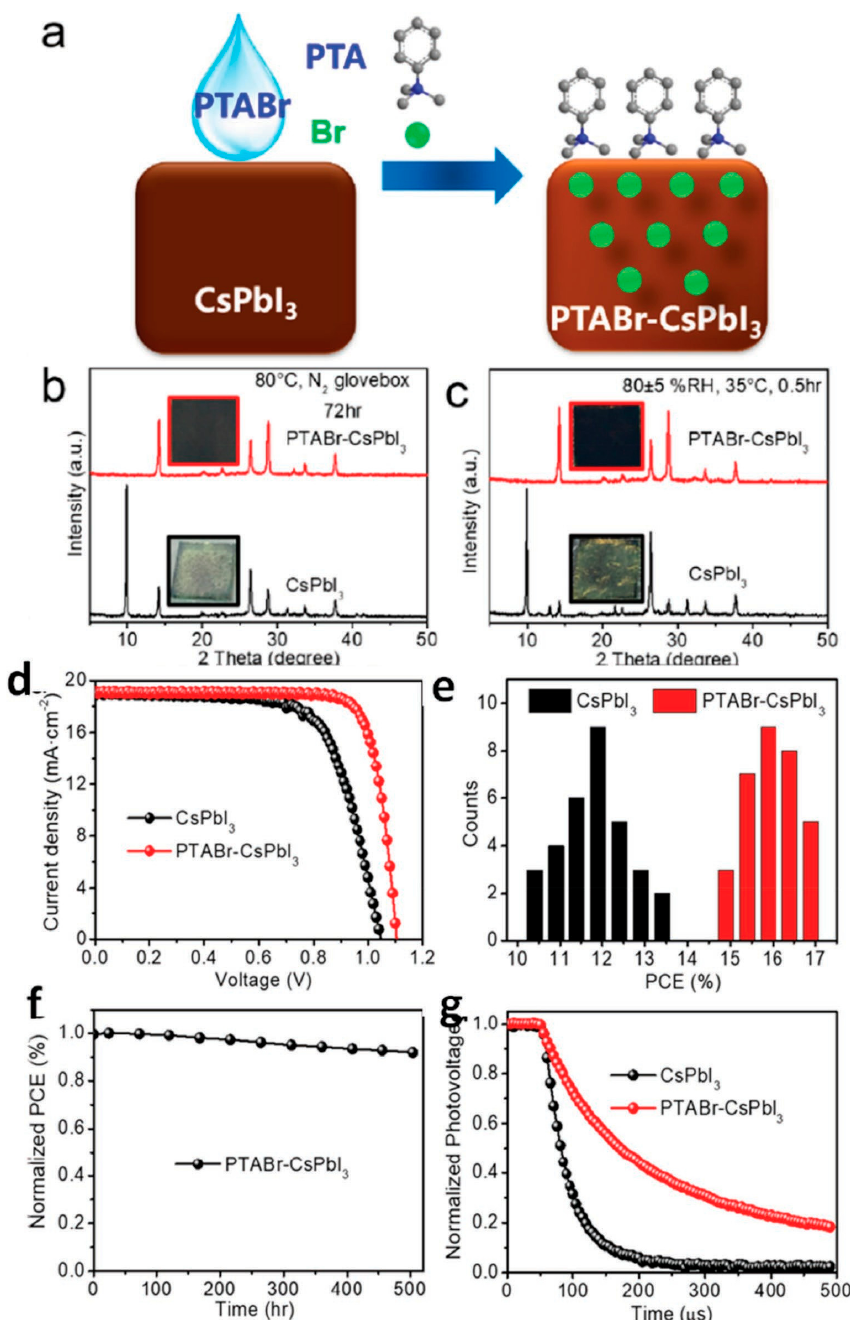
Figure 6. ( a ) Demonstration of gradient ‐ doping of Br and surface passivation of PTA cation on thin film of CsPbI 3 ; ( b ) X ‐ ray diffraction (XRD) pattern of PTABr–CsPbI 3 and CsPbI 3 perovskite thin film heated at 80 °C in a glovebox filled with N 2 for a duration of 72 h; ( c ) XRD pattern of CsPbI 3 and PTABr–CsPbI 3 perovskite thin film post exposure to a relative humidity (RH) of 80 ± 5% at ≈ 35 °C for a duration of 0.5 h; ( d ) J – V curves of CsPbI 3 and PTABr–CsPbI 3 based devices under AM 1.5 G simulated illumination condition of 100 mW cm − 2 during backward scan; ( e ) Histogram of PCE of CsPbI 3 ‐ and PTABr–CsPbI 3 ‐ based devices; ( f ) Normalized PCE of PTABr–CsPbI 3 ; and ( g ) normal ‐ ized output voltage of CsPbI 3 ‐ and PTABr–CsPbI 3 ‐ based devices. Adapted with permission from [58].